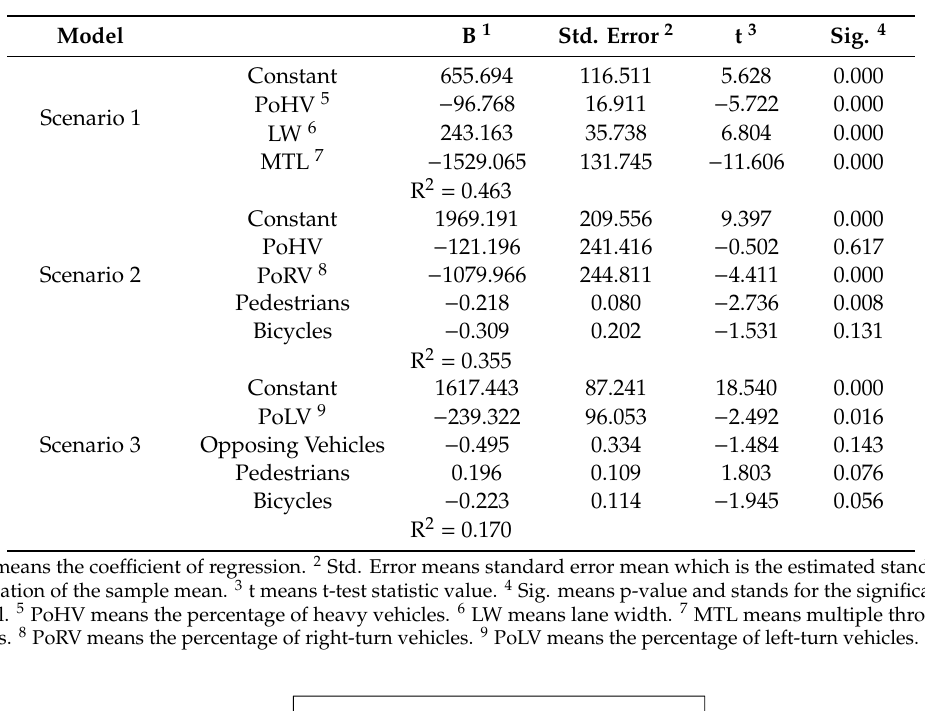
Table 5. Model parameters and goodness of fit.